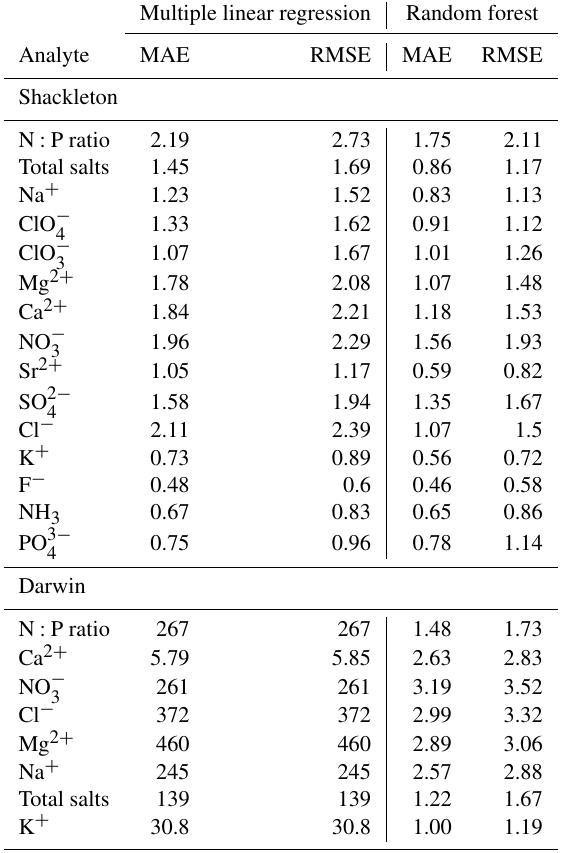
Table 4. Multiple linear regression and random forest mean abso- lute error (MAE) and root mean squared error (RMSE). All geo- chemical data were log-transformed for the analysis. Multiple linear regression Random forest